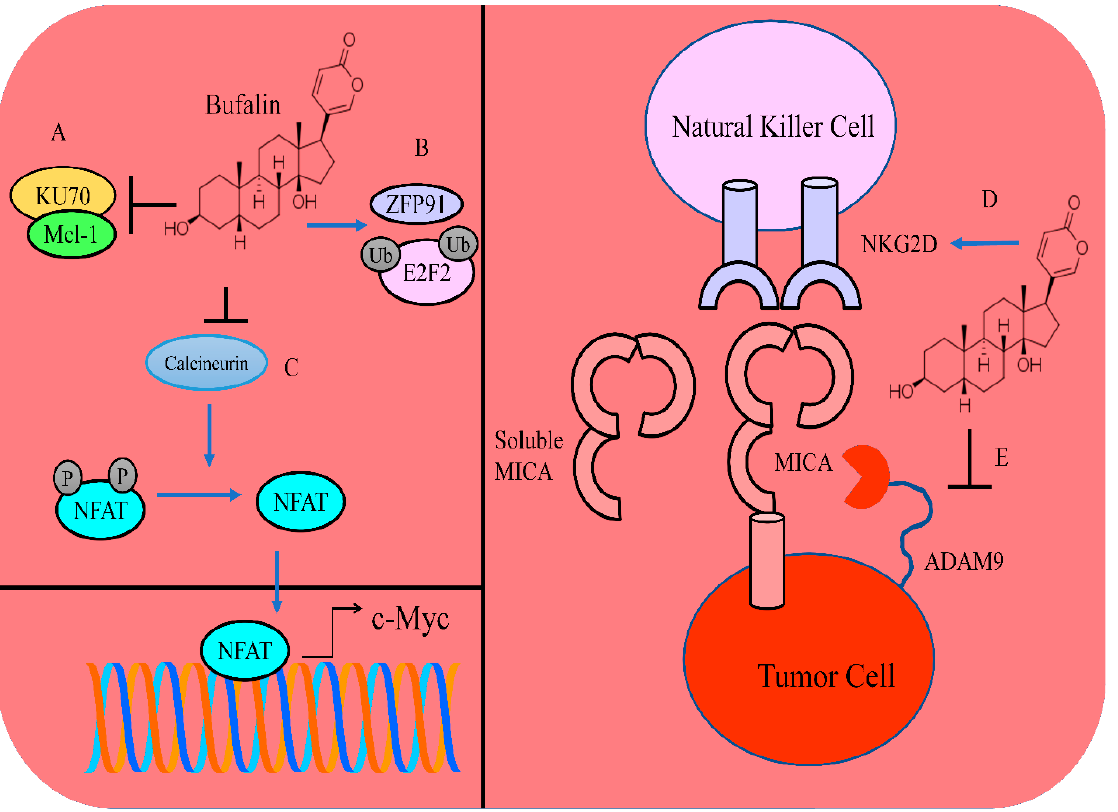
Figure 4. ( A ) Bufalin induced dissociation of KU70 and Mcl-1 and promoted degradation of Mcl-1. ( B ) Bufalin enhanced the interactions of ZFP91 and E2F2. Bufalin mediated an increase in the polyubiquitination levels of E2F2. ( C ) Bufalin inhibited calcineurin mediated dephosphorylation and nuclear accumulation of NFAT. NFAT stimulated the expression of c-Myc. ( D , E ) Bufalin enhanced the expression of NKG2D in natural killer cells. Bufalin reduced the levels of ADAM9 and inhibited the shedding of MICA.